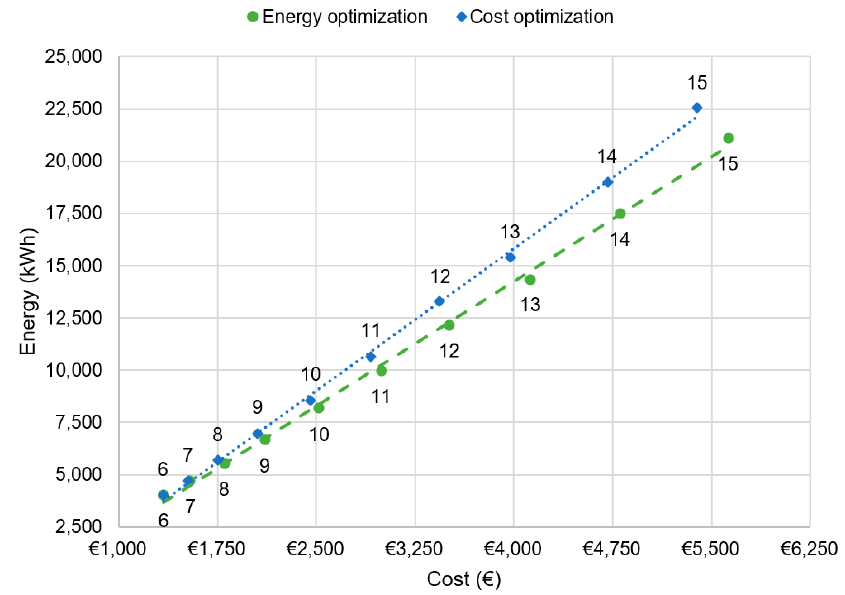
Figure 7. Relation between embodied energy and cost for the wall heights of the study, in m.